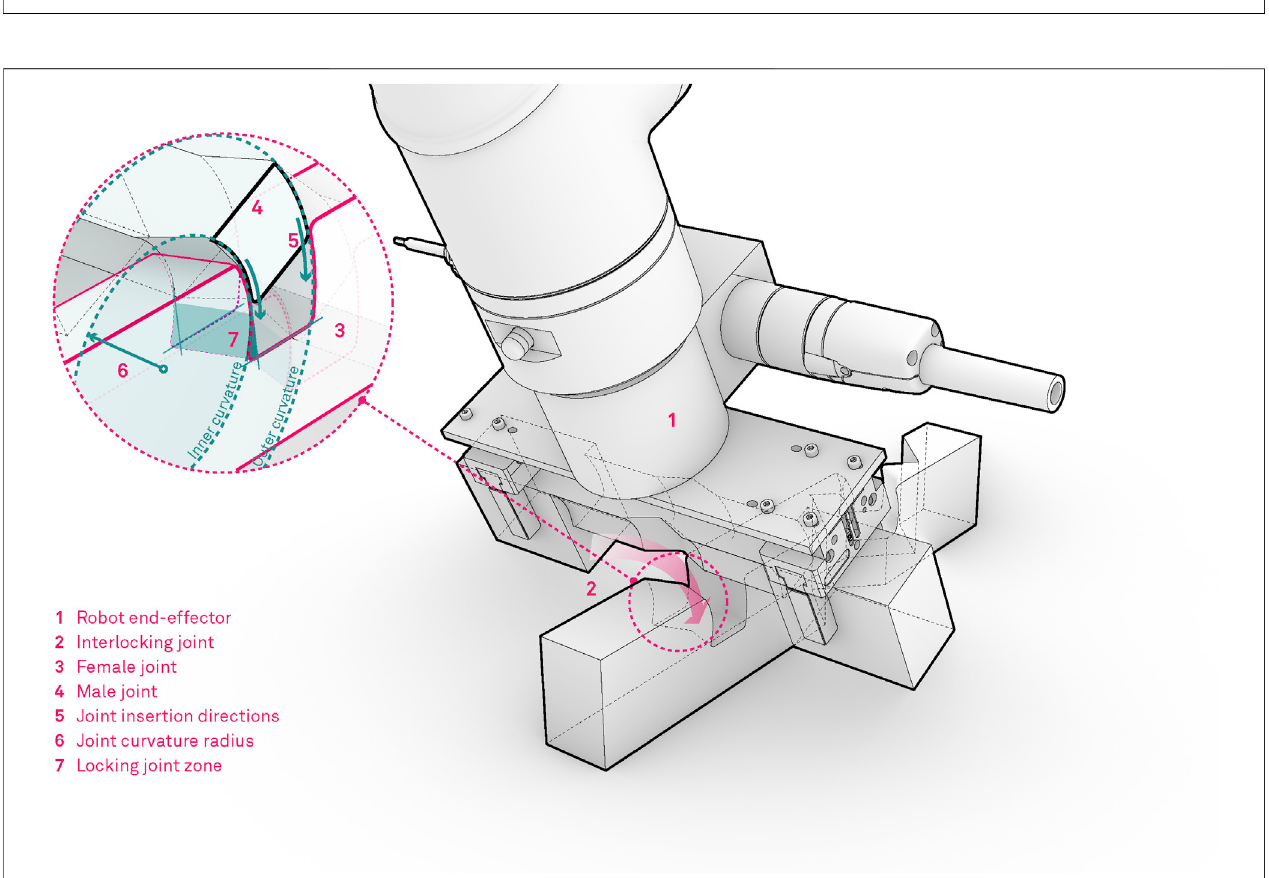
FIGURE 1 | The process of structural design inspired by Michell ’ s optimal truss: (A) Michell ’ s optimal truss, (B) Revised structure with reciprocal connections, (C) The fi nal structure made of timber studs.